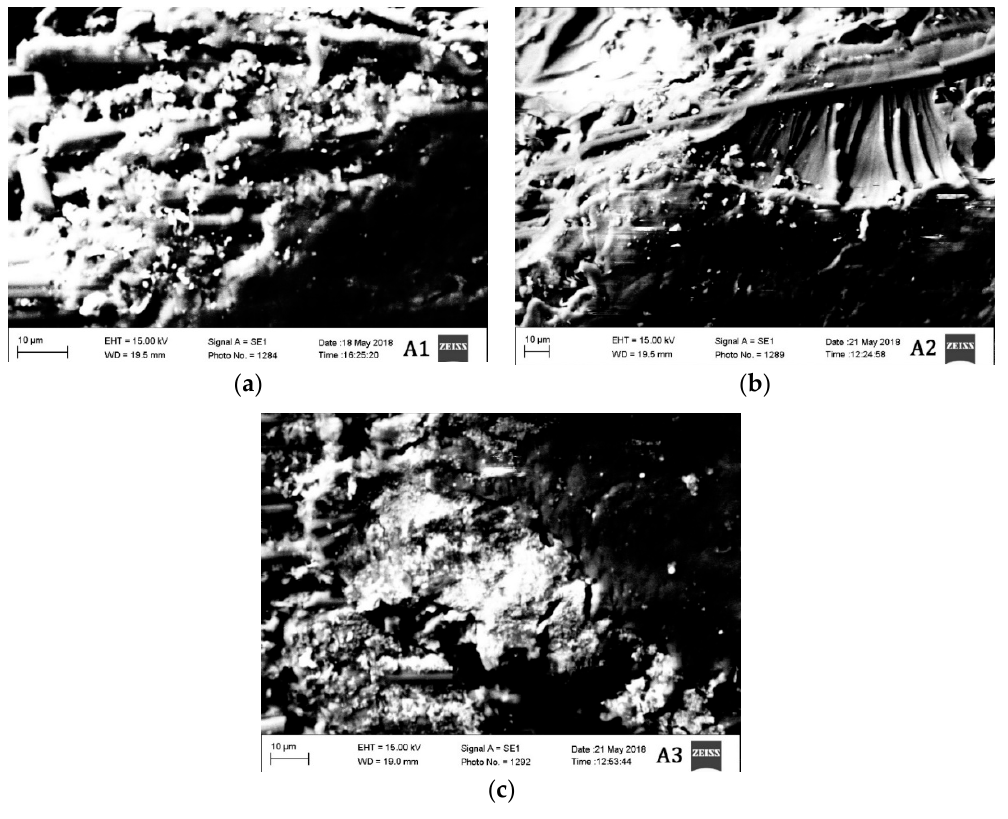
Figure 6. SEM Images of materials ( a ) A1, ( b ) A2, and ( c )A3.